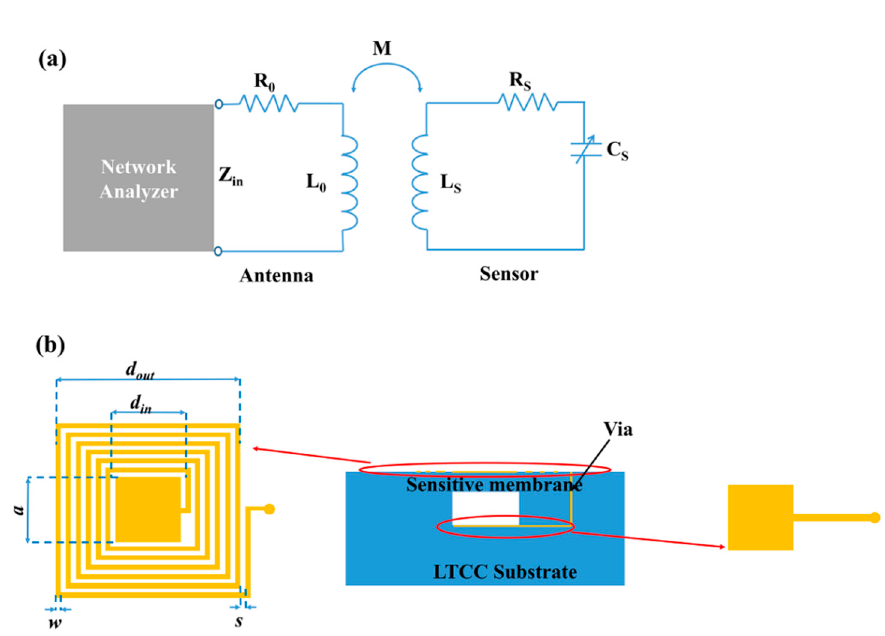
Figure 1. ( a ) Equivalent circuit of inductive coupling between the sensor and the reader antenna. ( b ) Schematic of the wireless LTCC pressure sensor.